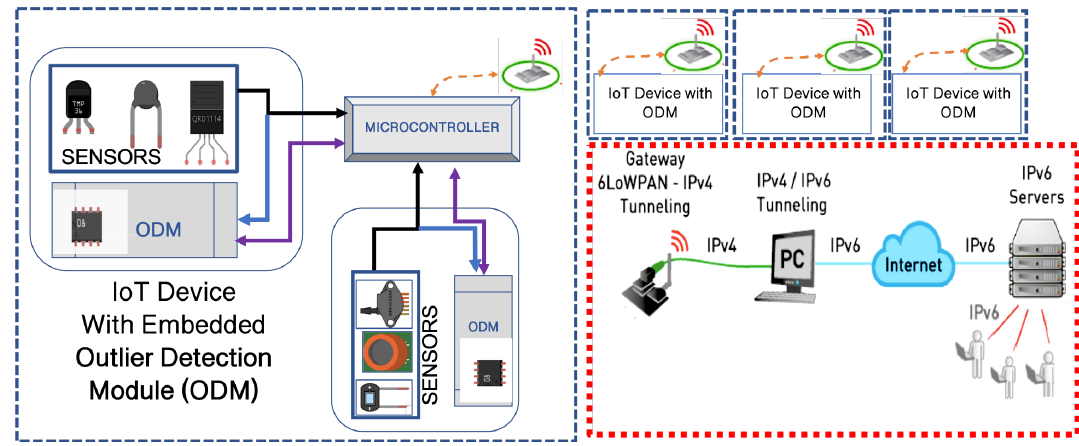
Figure 6. Outlier detection model for IoT sensors.